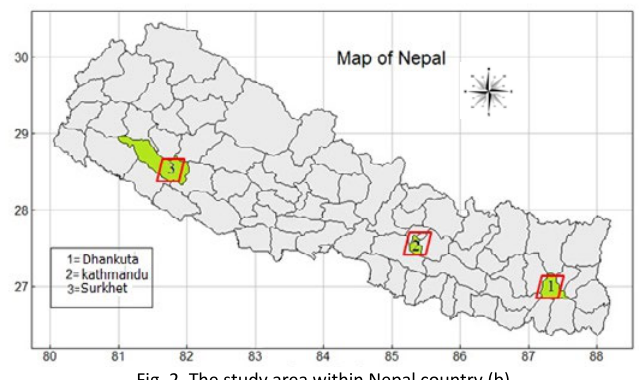
Fig. 2: the study area within Nepal country (b) Fig. 2. The study area within Nepal country